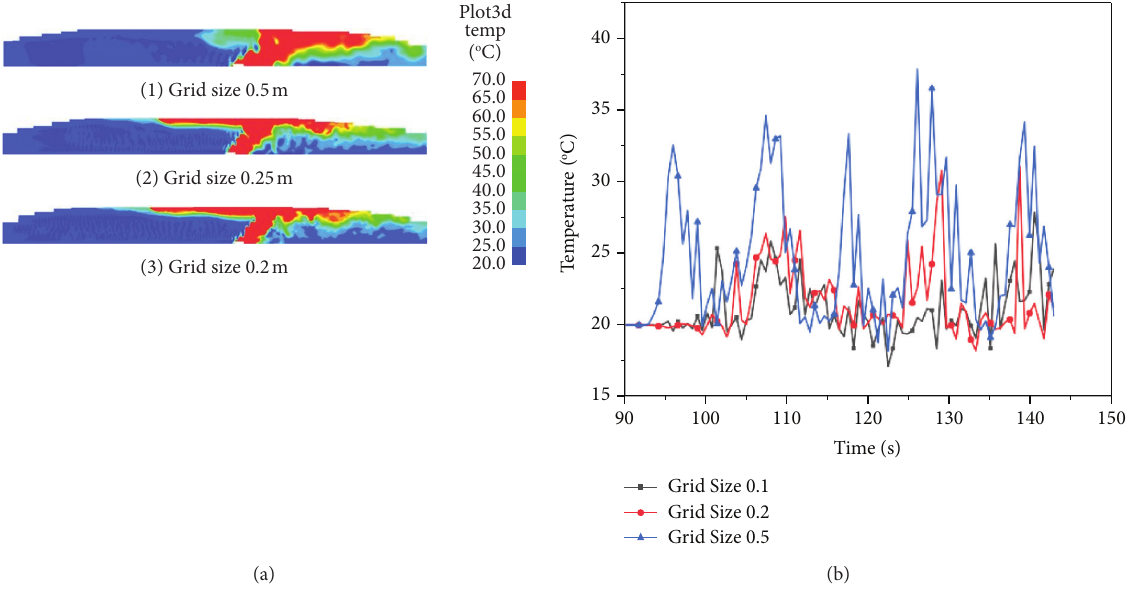
Figure 3: Grid sensitivity: comparison of temperature contour plots in the vertical midplane for 3 mesh cell sizes for simulation 11. (a) Temperature contour plots in the vertical midplane. (b) Temperature change curve at human eye height under different grid sizes.